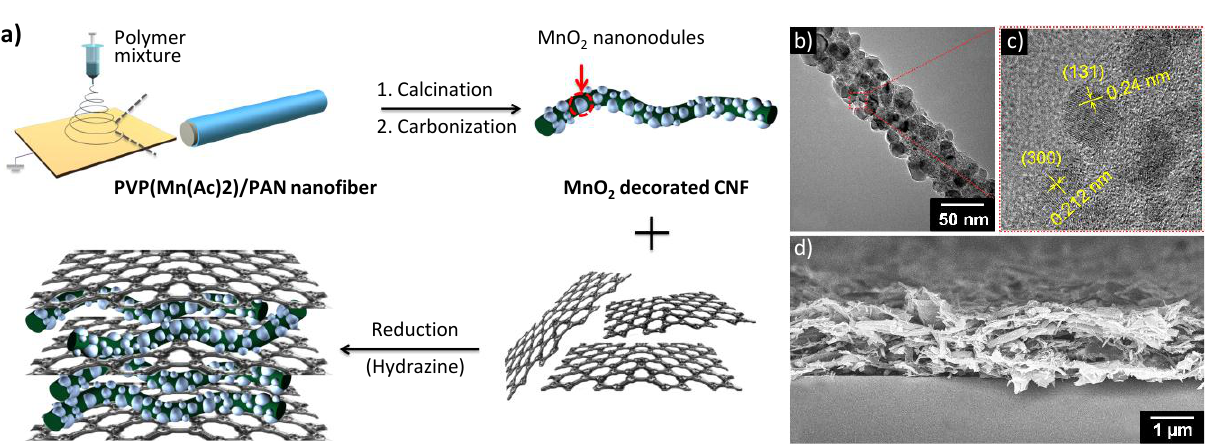
Figure 4. ( a ) Schematic of the fabrication of ternary hybrid nanostructures: MnO-decorated CNFs (MCNFs)/reduced graphene oxide (RGO) nanohybrids; ( b ) Typical transmission electron microscopy (TEM) image of MCNF; ( c ) High-resolution TEM image of an MCNF (lattice planes of γ-MnO 2 , such as (131) and (300), are marked); and ( d ) Cross-sectional scanning electron microscopy (SEM) image of MCNF/RGO nanohybrids (RGO 50 wt.%) deposited on a silicon wafer. With permission from [39]; Copyright 2013, Wiley-VCH Verlag GmbH & Co.